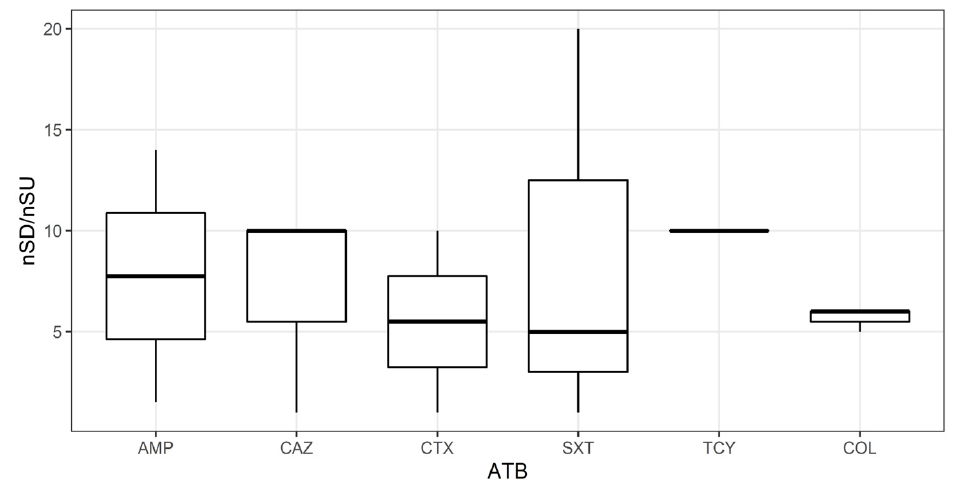
Figure 14. Downstream/upstream ratios (nSD/nSU) of the abundance of culturable Escherichia coli resistant to ampicillin (AMP), ceftazidime (CAZ), cefotaxime (CTX), sulfamethoxazole (SXT), tetracycline (TCY) and colistin (COL) measured in the river sediments.